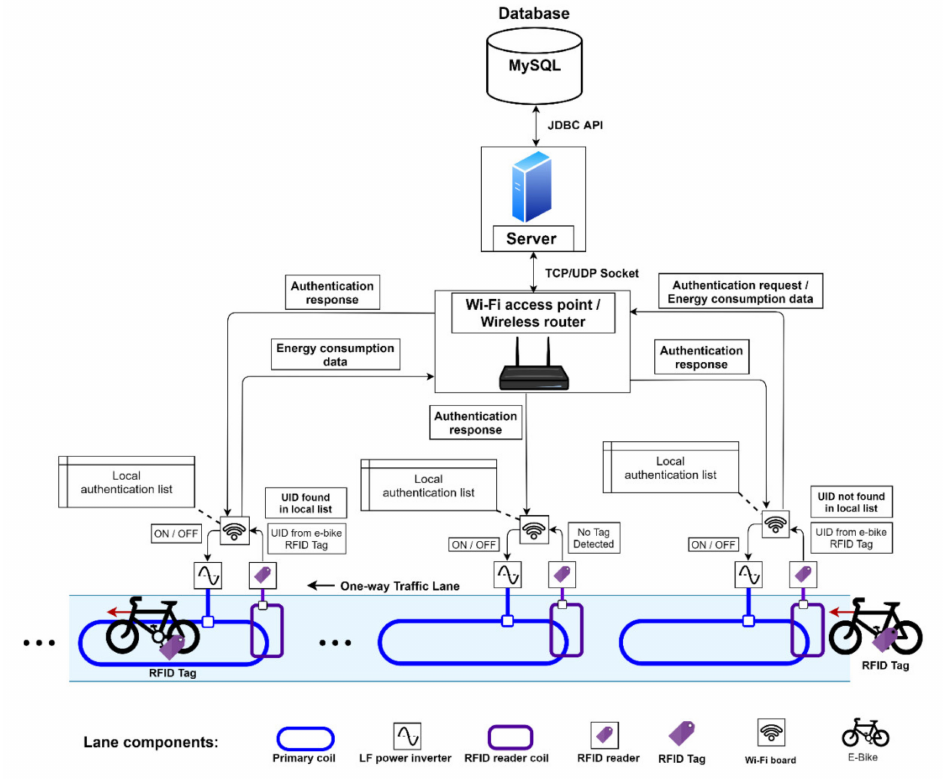
Figure 3. Architecture of the developed